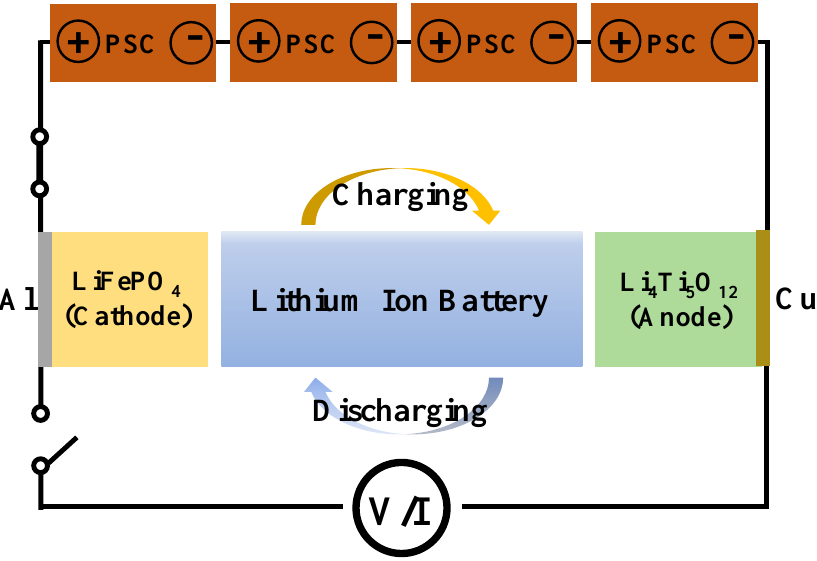
Figure 8. Schematic of the PSCs-lithium-ion batteries (LIB) coupling device.